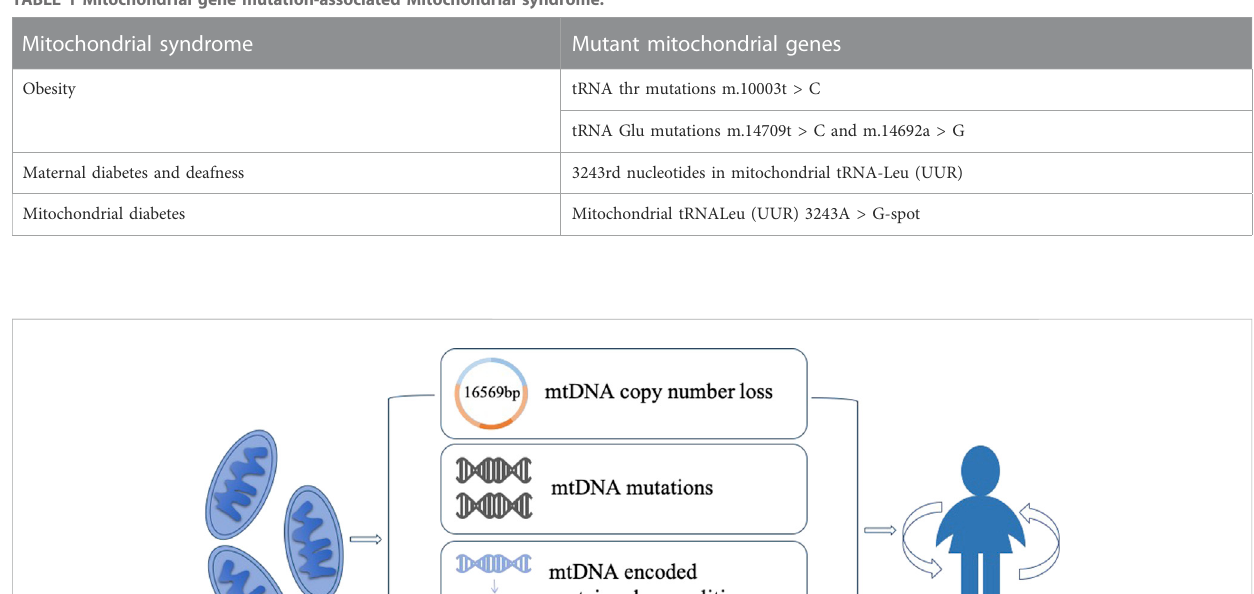
TABLE 1 Mitochondrial gene mutation-associated Mitochondrial